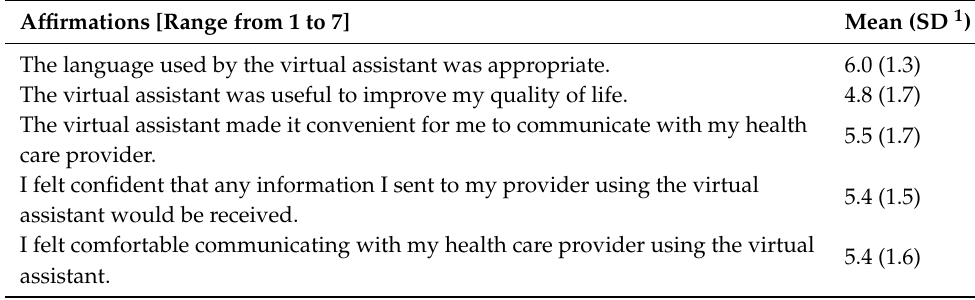
Table 5. Patients’ responses regarding the virtual assistant utility.